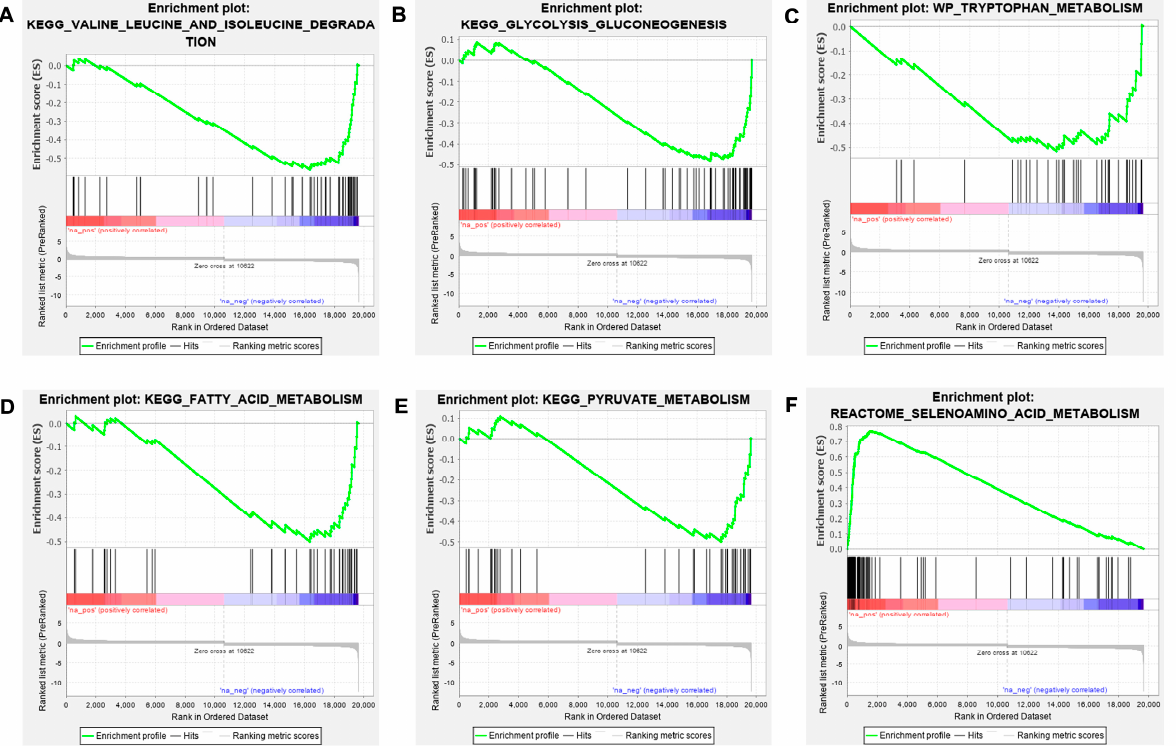
Figure 2. GSEA analysis of the enriched signaling pathways associated with metabolism in tlr2 wild type and mutant zebrafish larvae. ( A – E ) GSEA analysis results for tlr2 wild type zebrafish larvae group. ( F ) GSEA analysis results for tlr2 mutant zebrafish larvae group. The gene set C2 (cp.kegg.v.6.2.symbols.gmt) database was used to analyze the whole gene expression dataset of the tlr2 mutant zebrafish and its wild type control group. For more detailed information see Tables S3 and S4.